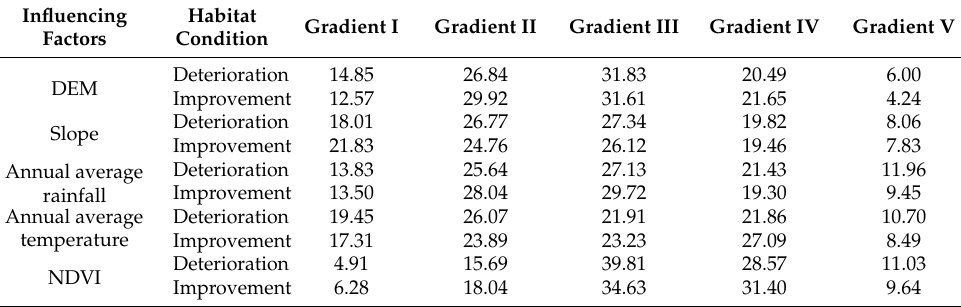
Table 9. Proportion of habitat quality condition in different gradients of each factor